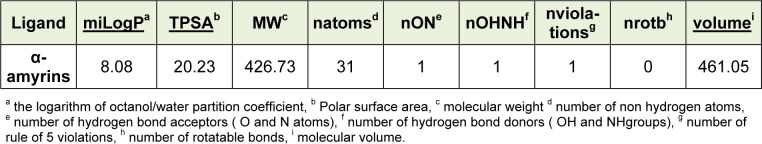
Molecular pharmacokinetic properties